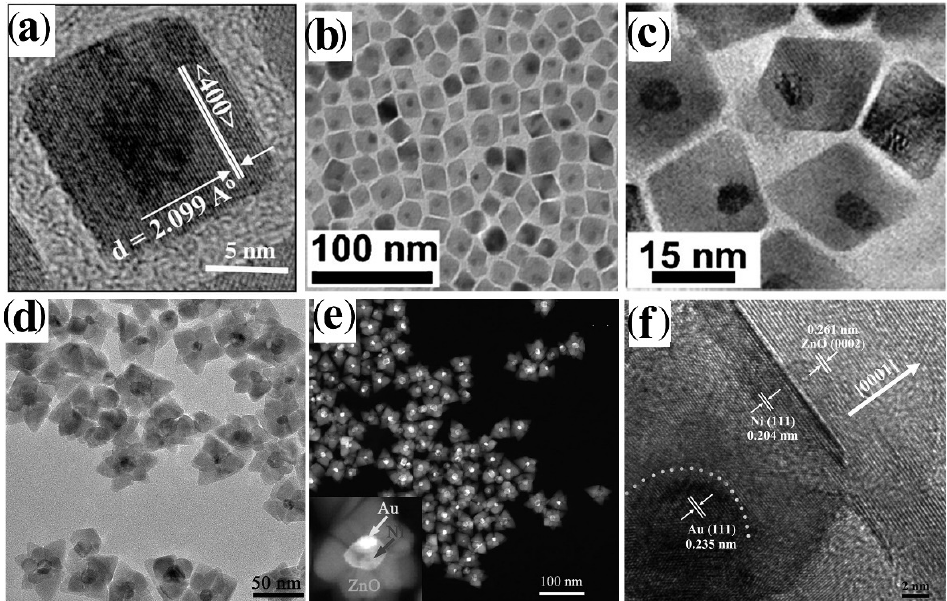
Figure 6. Gallery of representative core@shell CNHSs achieved by self-regulated nucleation-growth mechanisms (cf. Scheme 2f). The panels report: ( a – c ) TEM images of Co@Fe 2 O 3 CNHSs with rhombohedral-shaped shells (reproduced with permission from Ref. [203], Copyright 2011, Royal Society of Chemistry). ( d – f ) TEM, high-angle annular dark-field STEM, and HRTEM images